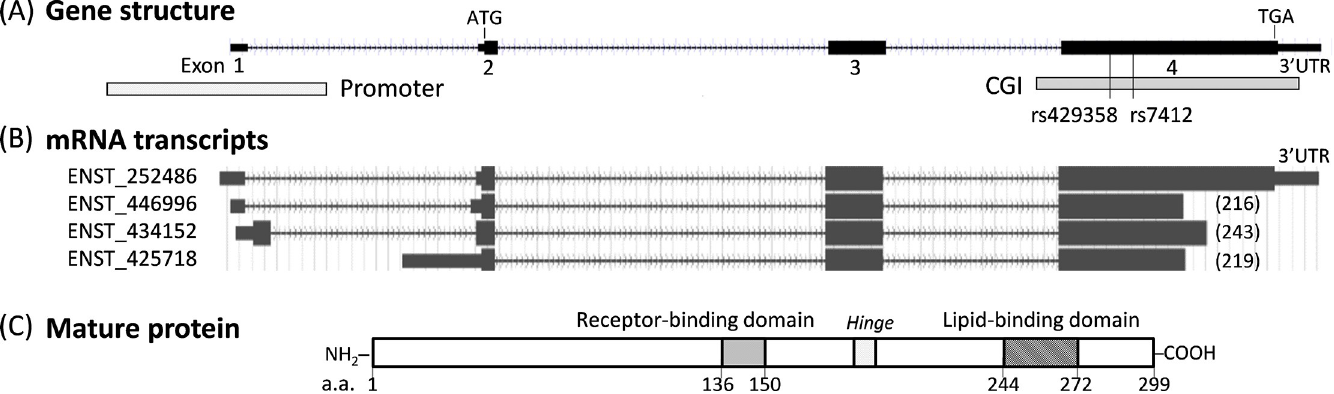
Fig 1. Structures of the APOE gene, RNA transcripts, and protein. (A) Map of APOE gene shows four exons, start and stop codons, two ε 2/ ε 3/ ε 4-defining SNPs, promoter, and CGI. (B) Map of various mRNA transcripts defined by Ensembl database. Numbers in parentheses indicate the amino acid position at the mRNA’s 3’ ending points. (C) Map of mature ApoE protein with domain structures. Numbers indicate amino acid positions. CGI: CpG island; SNP: single-nucleotide polymorphism.